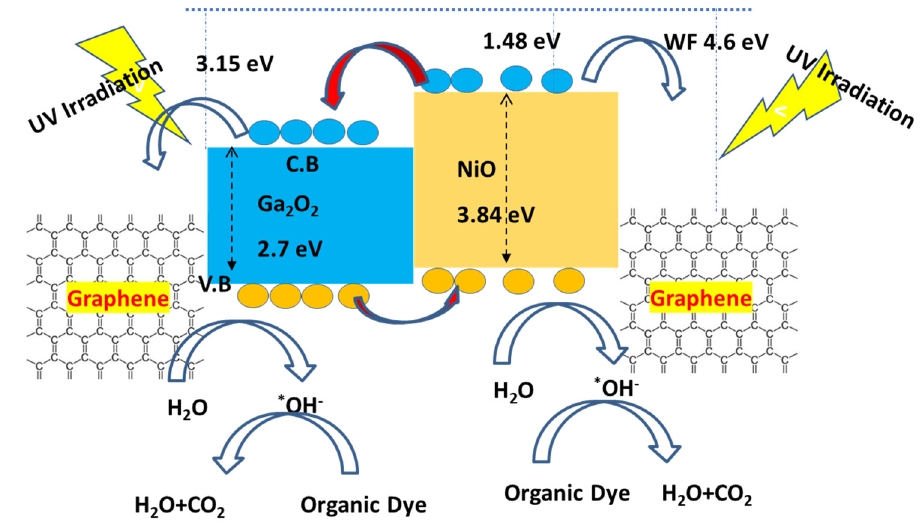
Figure 10. The proposed mechanism for the photodegradation of cationic dye by NiO/Ga 2 O 2 /Graphene nanocomposites.